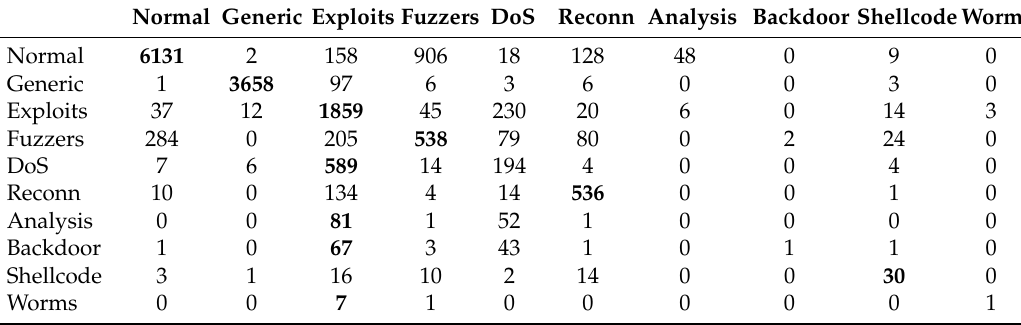
Table 9. Confusion matrix of UNSW-NB15 dataset with optimal parameters K and σ .